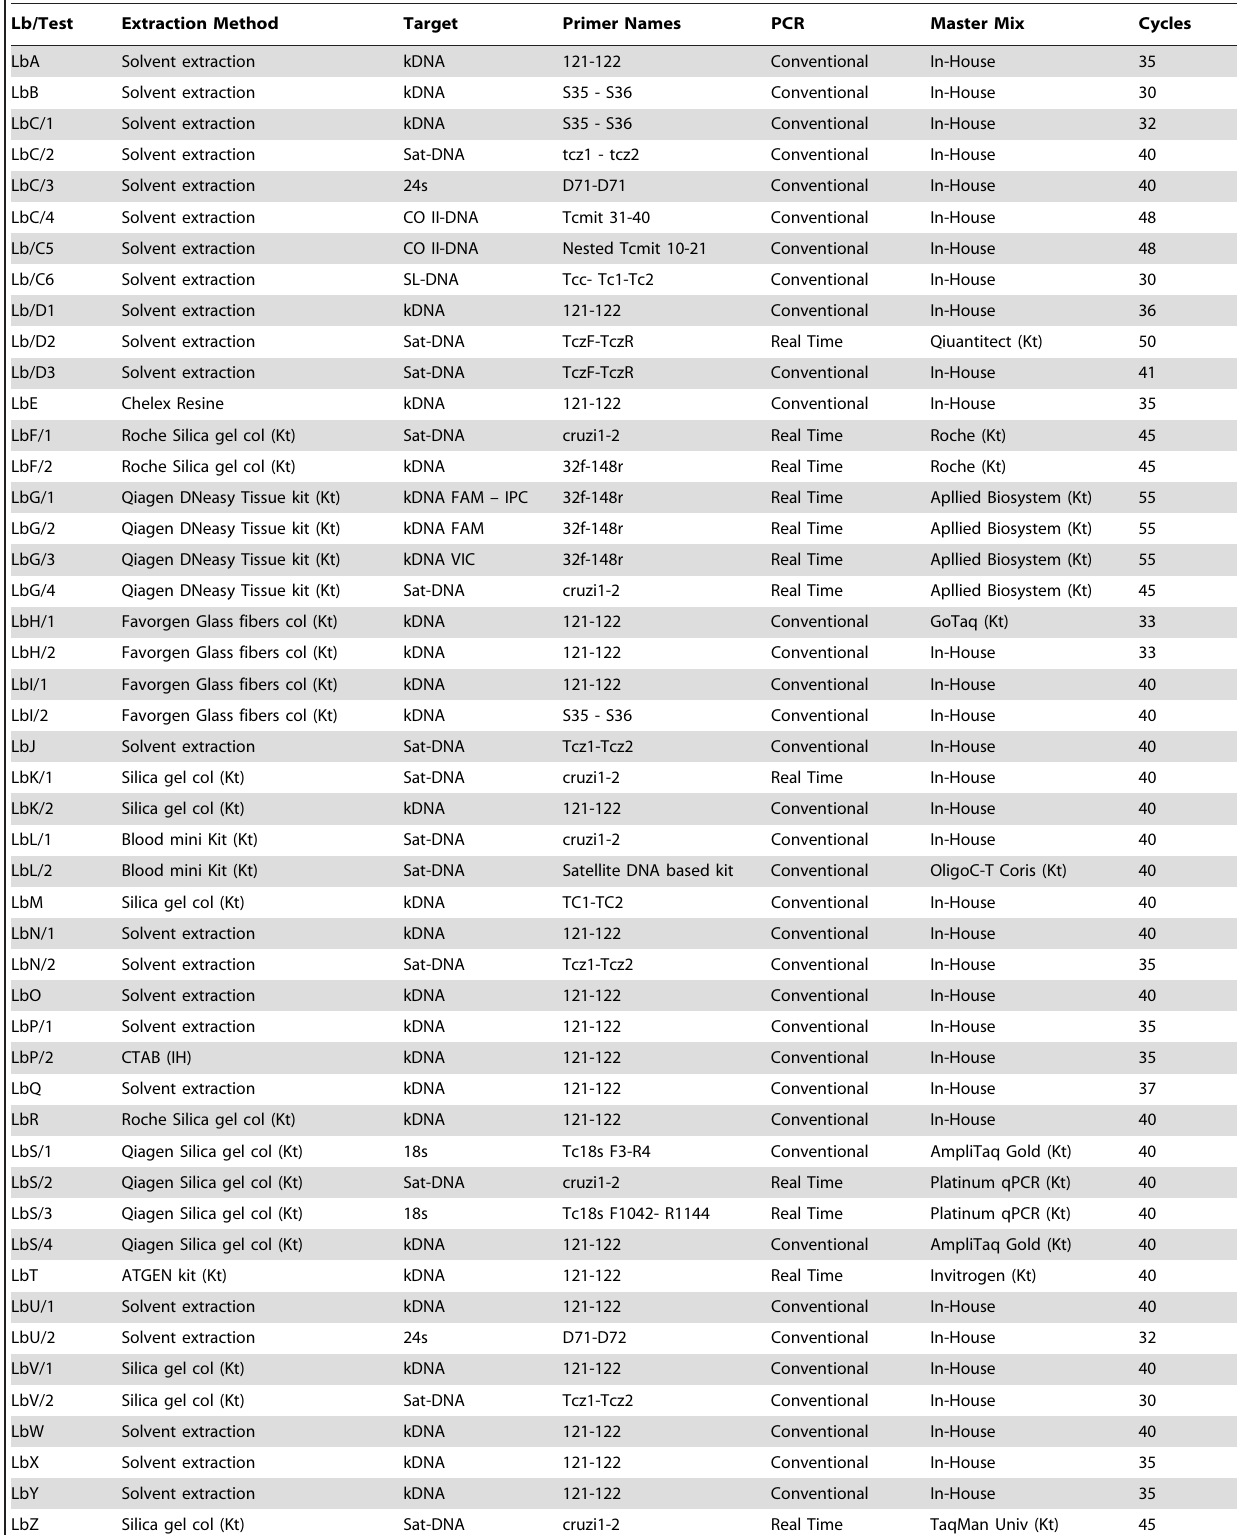
Table 1. PCR tests reported by the participating